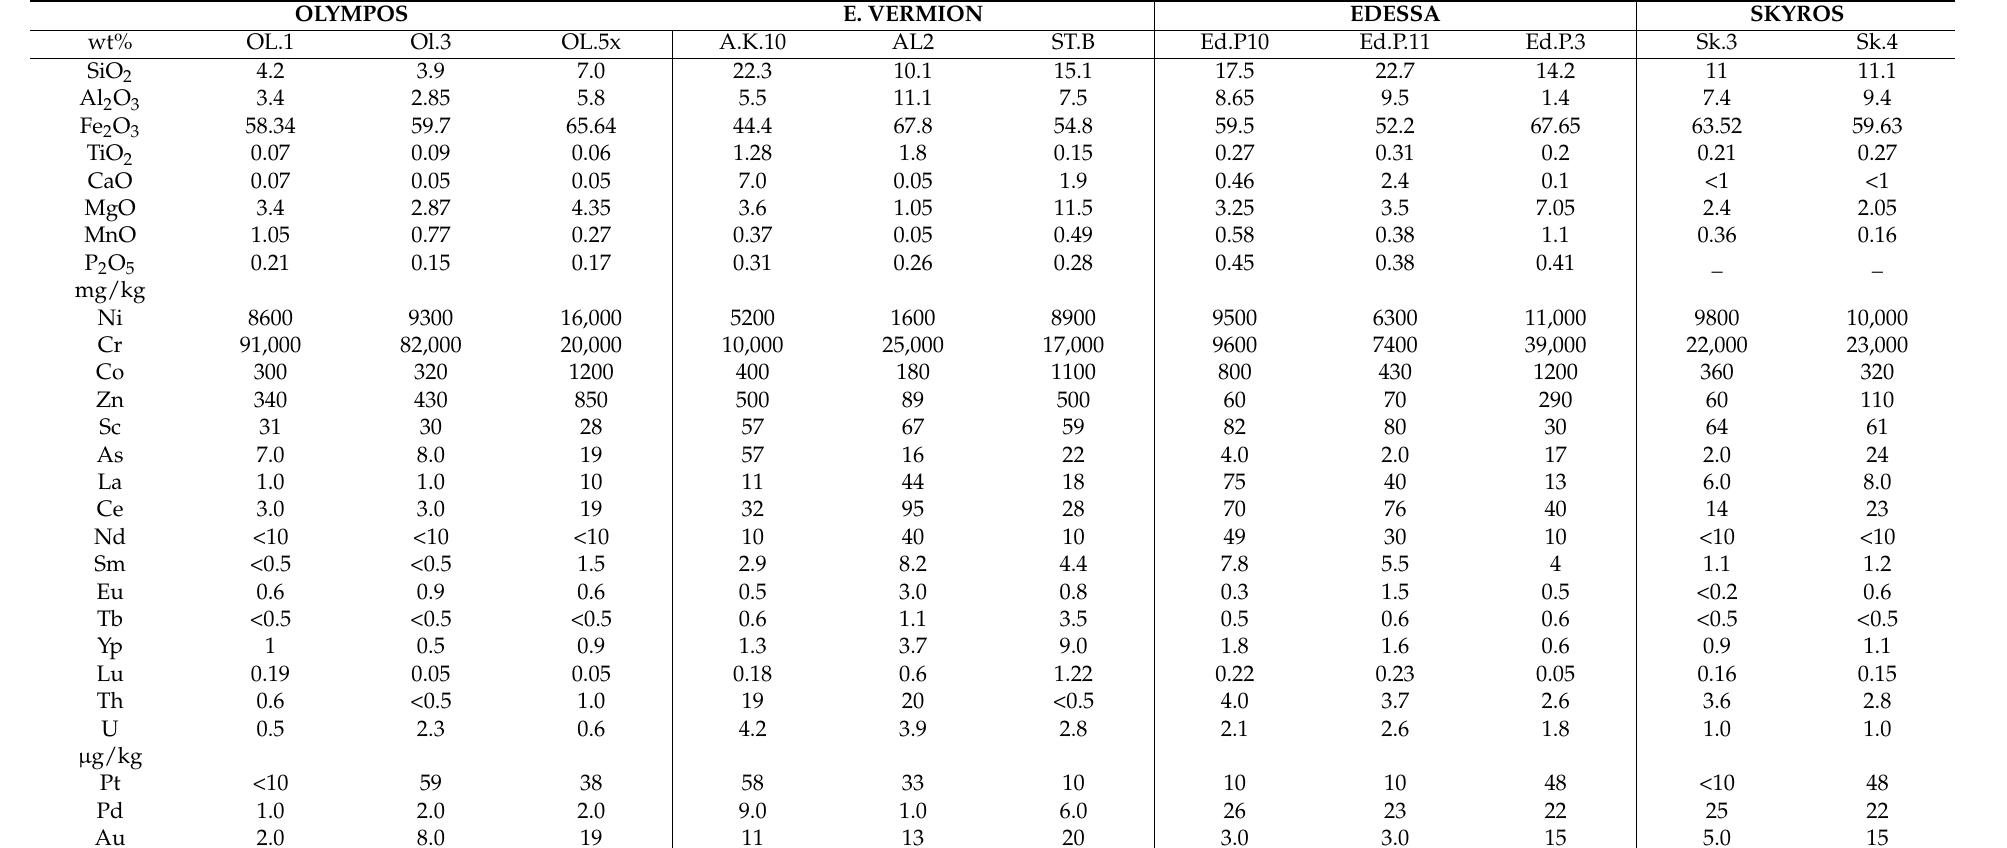
Table 4. Major and trace element contents from metamorphosed laterite occurrences of northern